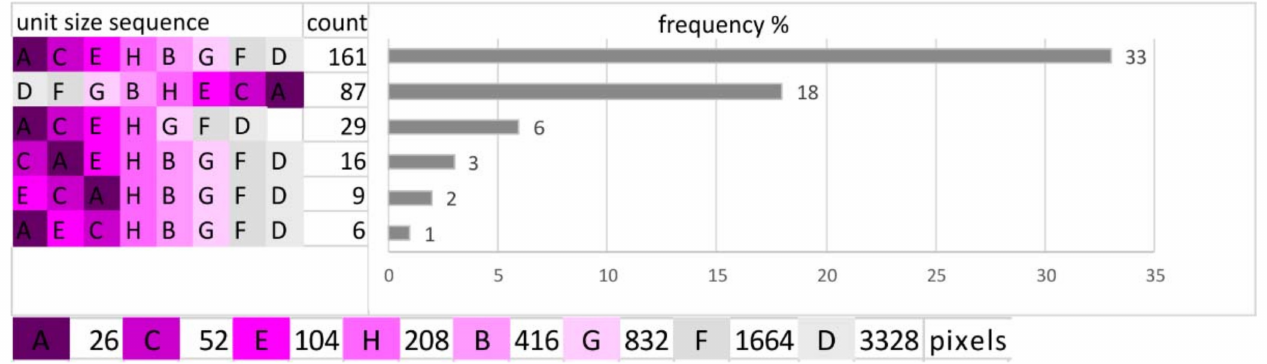
Figure 4. The most frequent EUS sequences made by